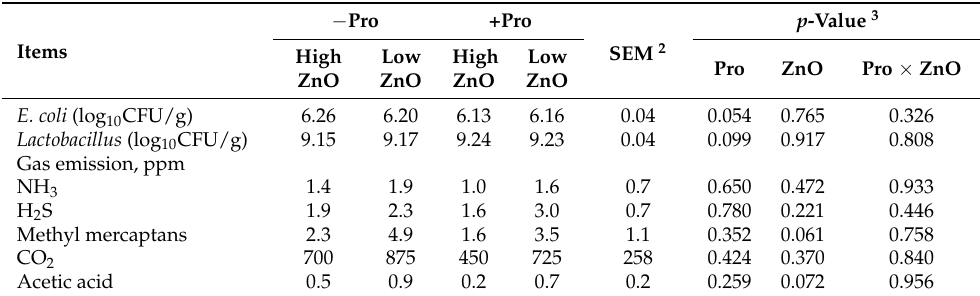
Table 3. Effects of ‘SynerZymeF10’ supplementation in ZnO diets on fecal microbiota and gas emission in weaning pigs 1